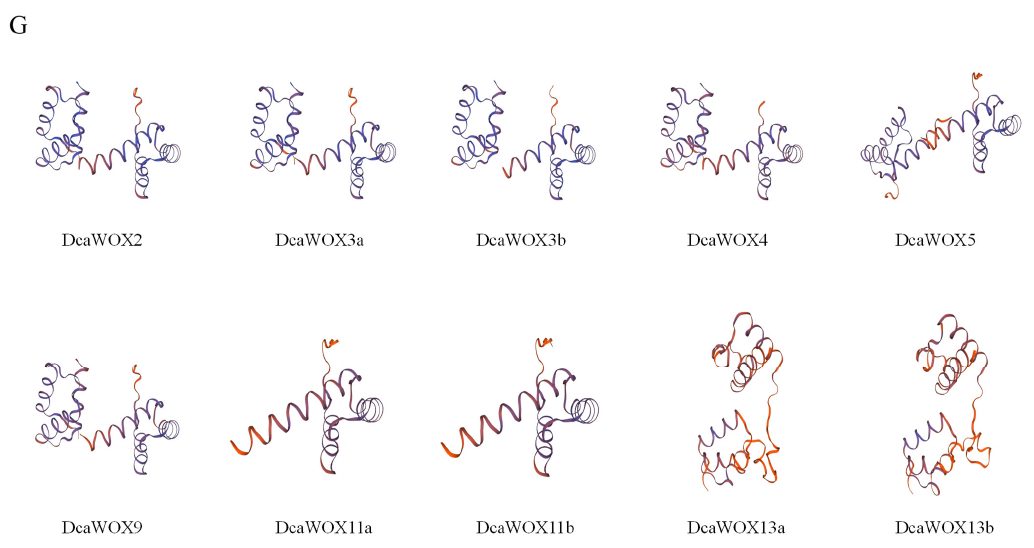
Figure 2. D. catenatum WOX gene structures and the conserved motifs in the encoded proteins. ( A ) Alignment of the homeodomain. (* Indicates the separation of every ten amino acid residues) ( B ) Phylogenetic tree of D. catenatum WOX proteins. ( C ) DcaWOX gene structure. ( D ) Cis-acting elements in the DcaWOX gene promoters. ( E ) Homeodomain revealed by SMART. ( F ) Conserved motifs in D. catenatum WOX proteins identified by MEME. Each motif is indicated by a specific color. ( G ) Three-dimensional conformation of D. catenatum WOX proteins.